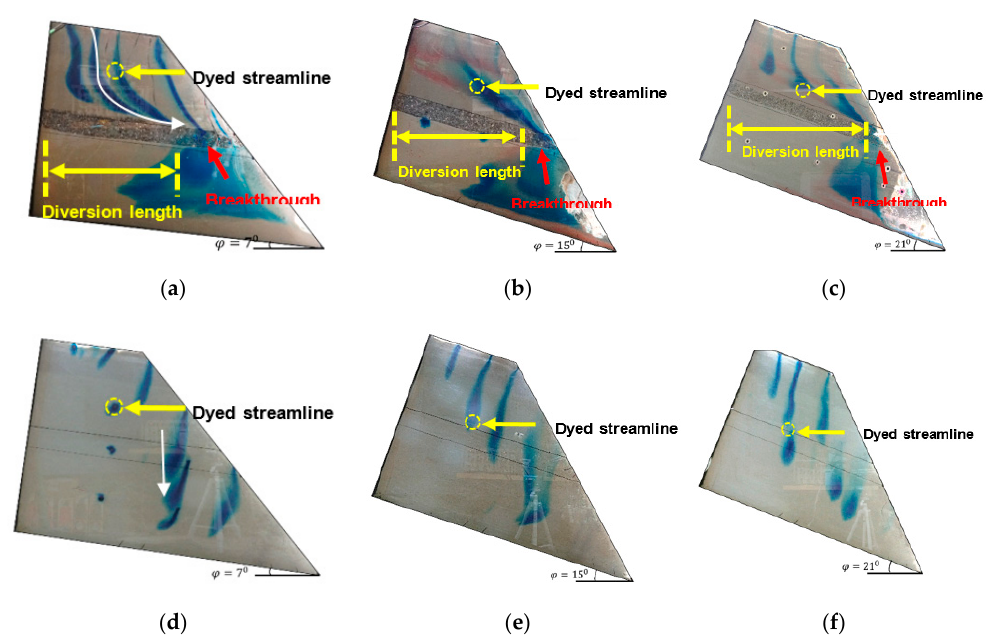
Figure 12. Side view of model experiments with blue dye traces during rainfall for the slopes in the inclined group. ( a ) case II (tilt angle α = 7°); ( b ) case III (tilt angle α = 15°); ( c ) case VI (tilt angle α = 21°) ; ( d ) case VI (tilt angle α = 21°) ; ( e ) case VII (tilt angle α = 21°) ; ( f ) case VIII (tilt angle α = 21°).The